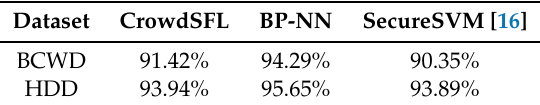
Table 1. Test accuracy.